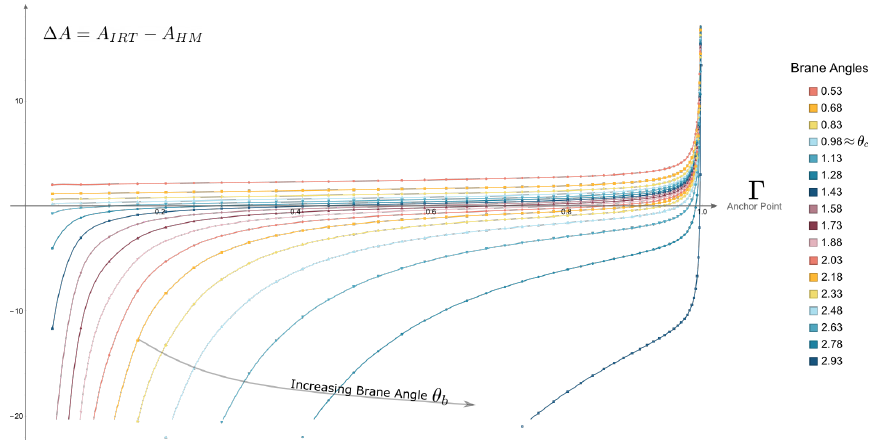
Figure 7 . The area difference is displayed as a function of CFT anchor point Γ for many possible brane angles θ . The area difference is clearly monotonically increasing in Γ and monotonically b decreasing in θ . The islands become dominant when the area difference is negative, which is b possible only above the Page angle. The Page angle [95] is very slightly less than the critical angle ( θ 0 . 98687 in d = 4 ). The area difference diverges to negative infinity as Γ → 0 for θ c ≈ but when Γ → 0 for θ it converges to a finite value. We explain in section 3.3 that the area b < θ c difference diverges to positive infinity as θ 0 b →